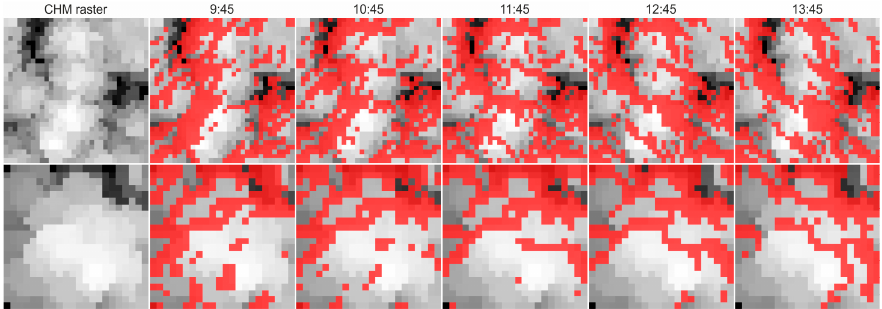
Figure 3. Canopy height model (CHM) raster images of trees measured using a spectrometer. On the left side we show the structure of tree crowns as seen from above. Raster images are on a greyscale that indicates identified height of the pixel in the canopy. The upper row includes raw and α S images of spruce trees, lower row shows dynamics of beech tree. Dynamics of estimated shadow fraction in this area in 1 h steps near midday are shown with red color. Pictures show dynamics of shadows on 5 July.